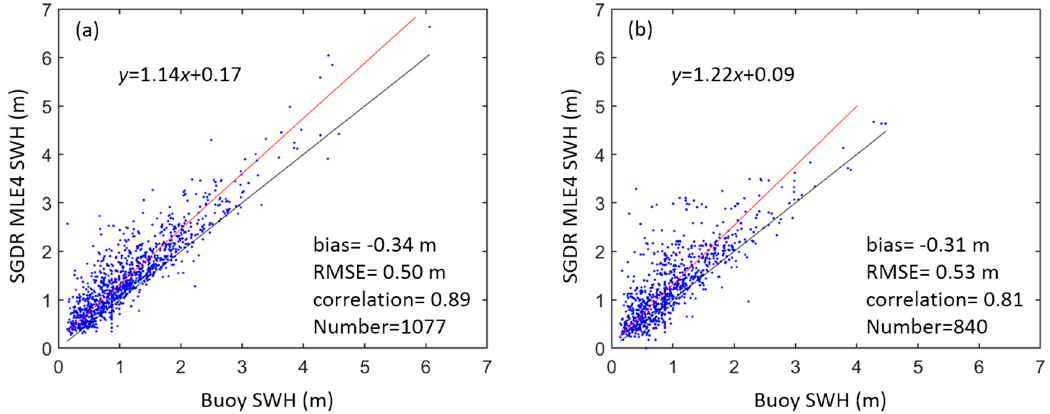
Figure 4. Similar to Figure 3, but for the results from the SGDR MLE4.